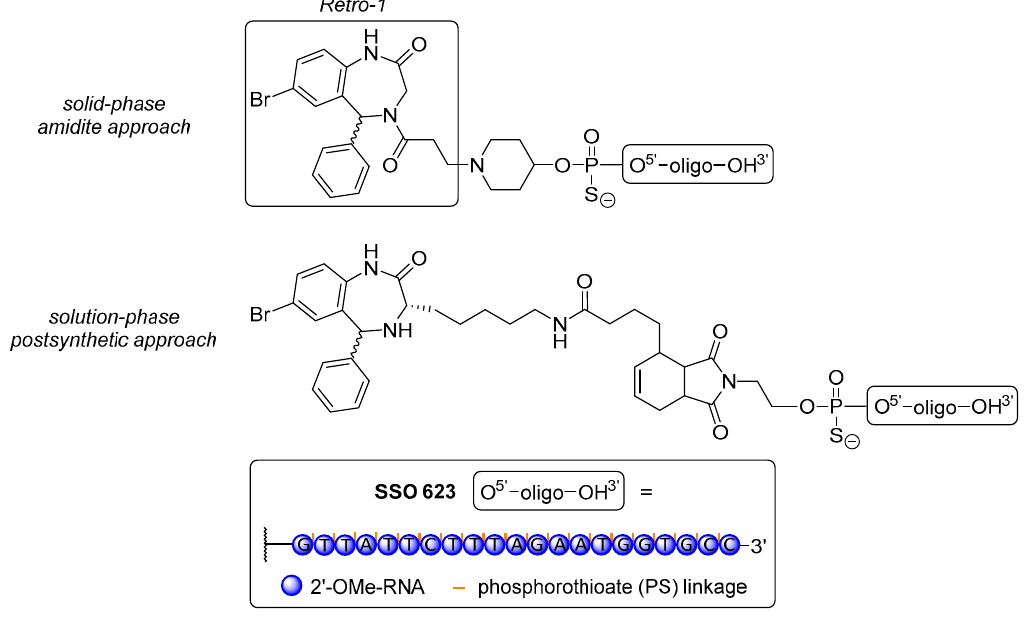
Figure 6. Retro-1 conjugates with the splice-switching ON SSO 623. ( Top ) on-resin conjugation product of Retro-1 with the ON using a 4-hydroxypiperidine-phosphoramidite. ( Bottom ) postsynthetic conjugation product of a Retro-1 derivative with the SSO via Diels-Alder reaction.